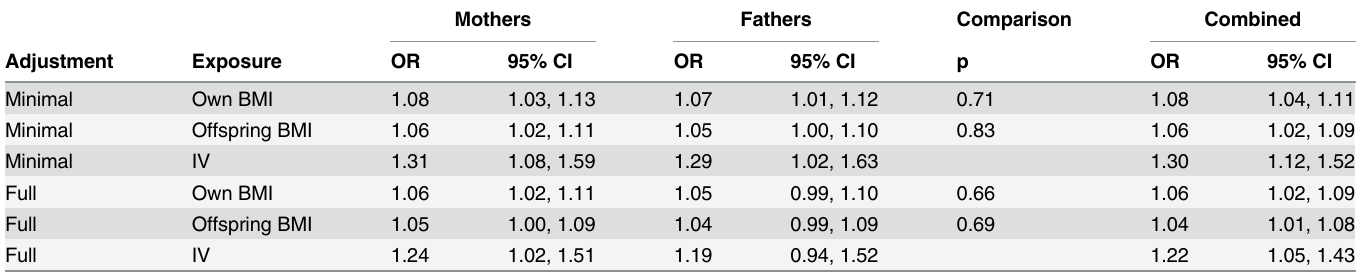
Table 3. Odds ratio for depression (HADD > = 8) per sex-specific SD of body mass index. Mothers Fathers Comparison